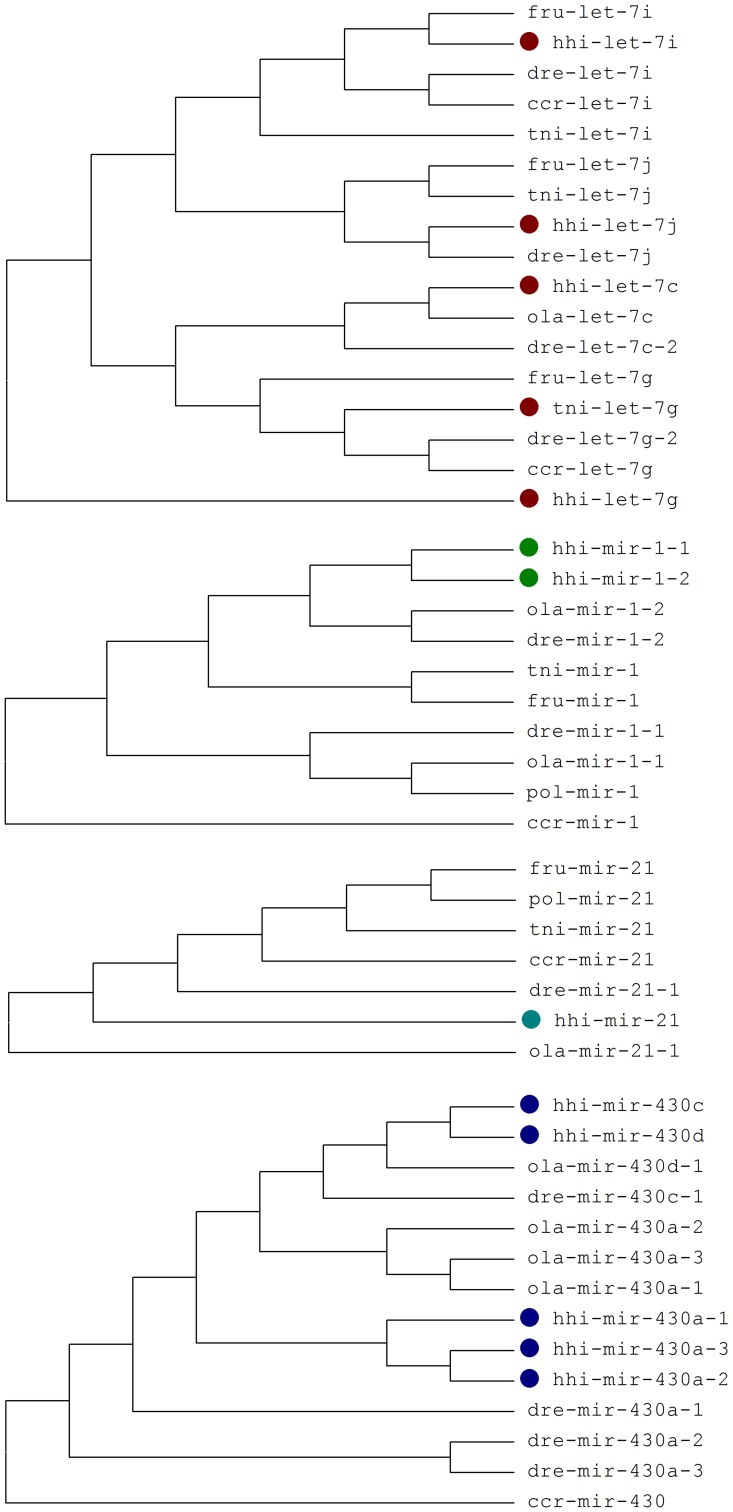
Phylogenetic trees for selected four miRNA families.The trees were constructed using maximum parsimony method using MEGA4. The precursor sequences for various teleost species were downloaded from miRBase. The abbreviations are: ccr (Cyprinus carpio); dre (Danio rerio), fru (Fugu rubripes); hhi (Hippoglossus hippoglossus); ola (Oryzias latipes), pol (Paralichthys olivaceus), and tni (Tetraodon nigroviridis).